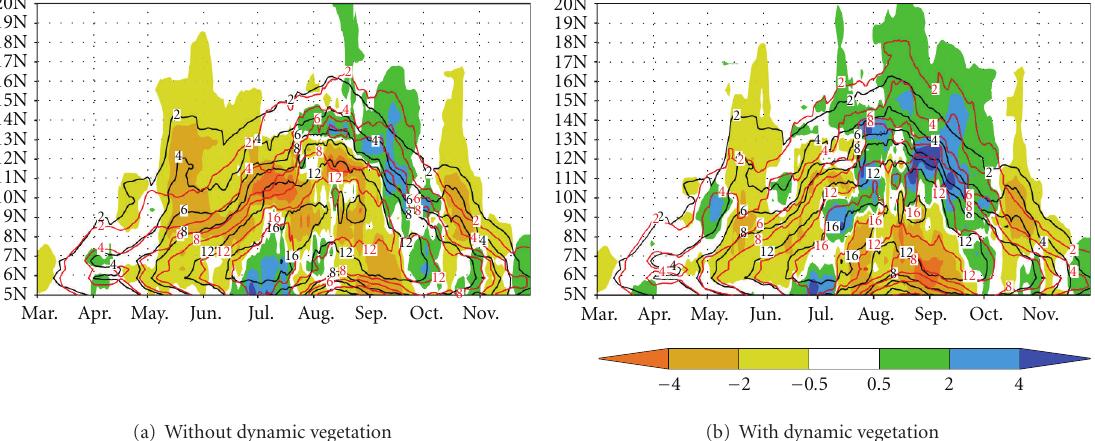
Figure 3: Predicted daily precipitation changes (color shading, in mm/day) during March–November, with variability more frequent than 11 days filtered out. The contour lines represent the 11-day filtered daily precipitation during 1984–1993 (black) and during 2084–2093